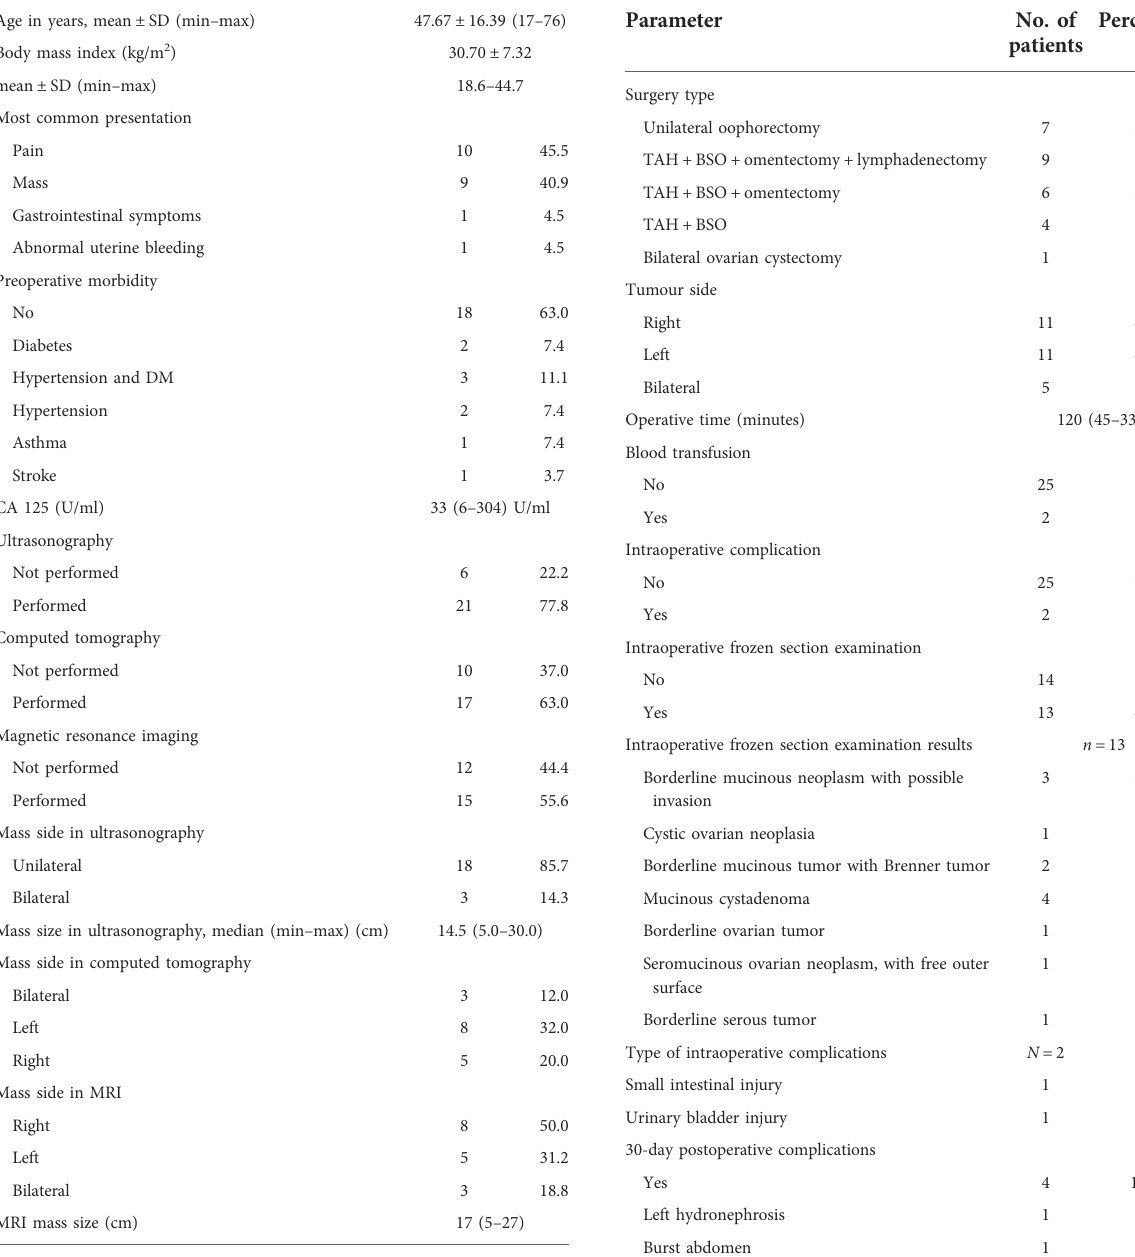
TABLE 1 Sociodemographic characteristics and radiological data of the studied